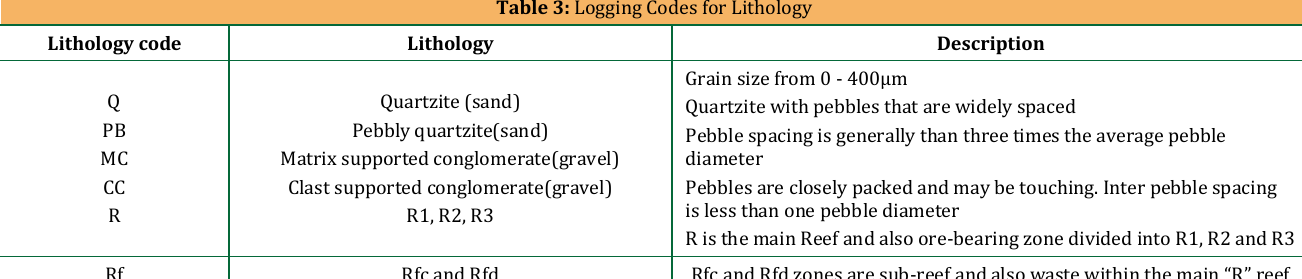
Table 3: Logging Codes for Lithology